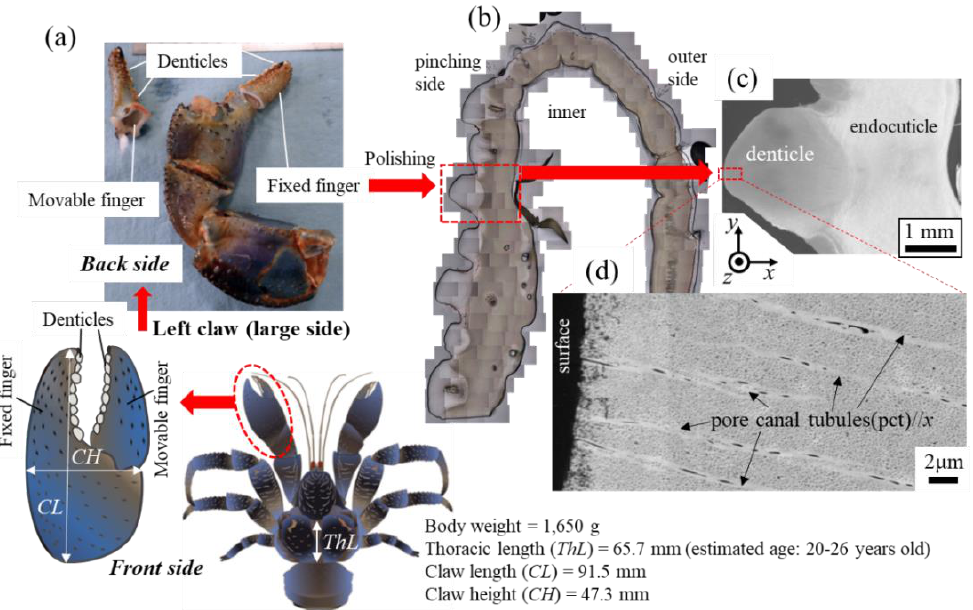
Figure 1. ( a ) Photographs of the left claw of the coconut crab used in the present study. Here, the movable finger was broken from the claw through the joint, and the fixed finger was cut by a saw. ( b ) Optical micrographs of a cross section of the fixed finger after polishing [20]. ( c ) Scanning electron microscope (SEM) image of the exoskeleton with the denticle on the pinching side and ( d ) a high-magnification SEM image of the denticle top.